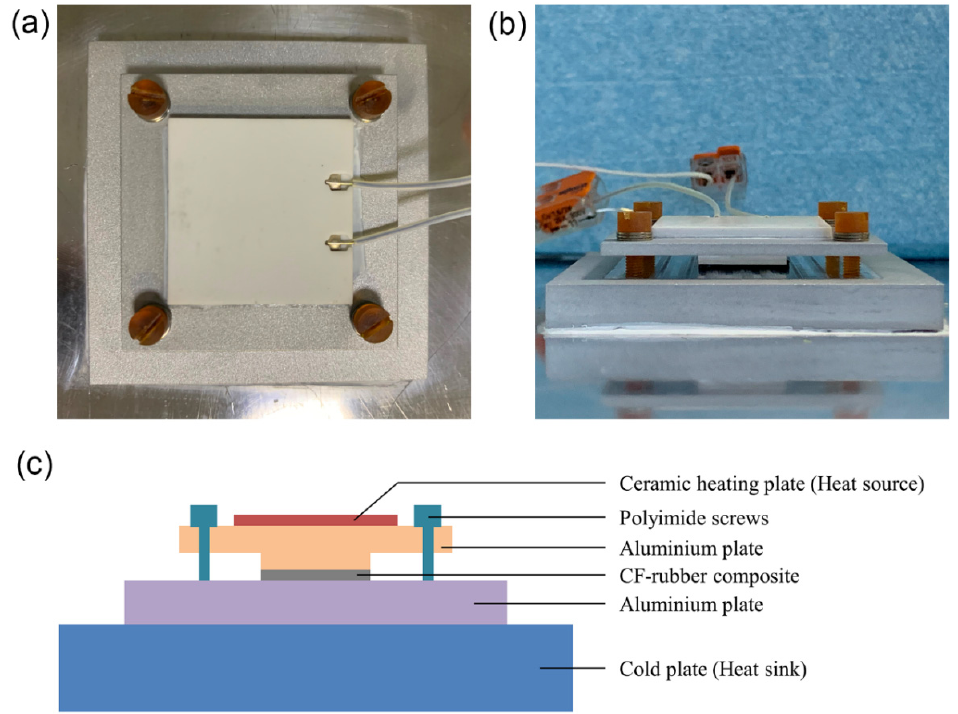
Figure 11. Optical photographs and schematic diagram of the test system. ( a ) Top view; ( b ) front view; ( c ) schematic diagram.